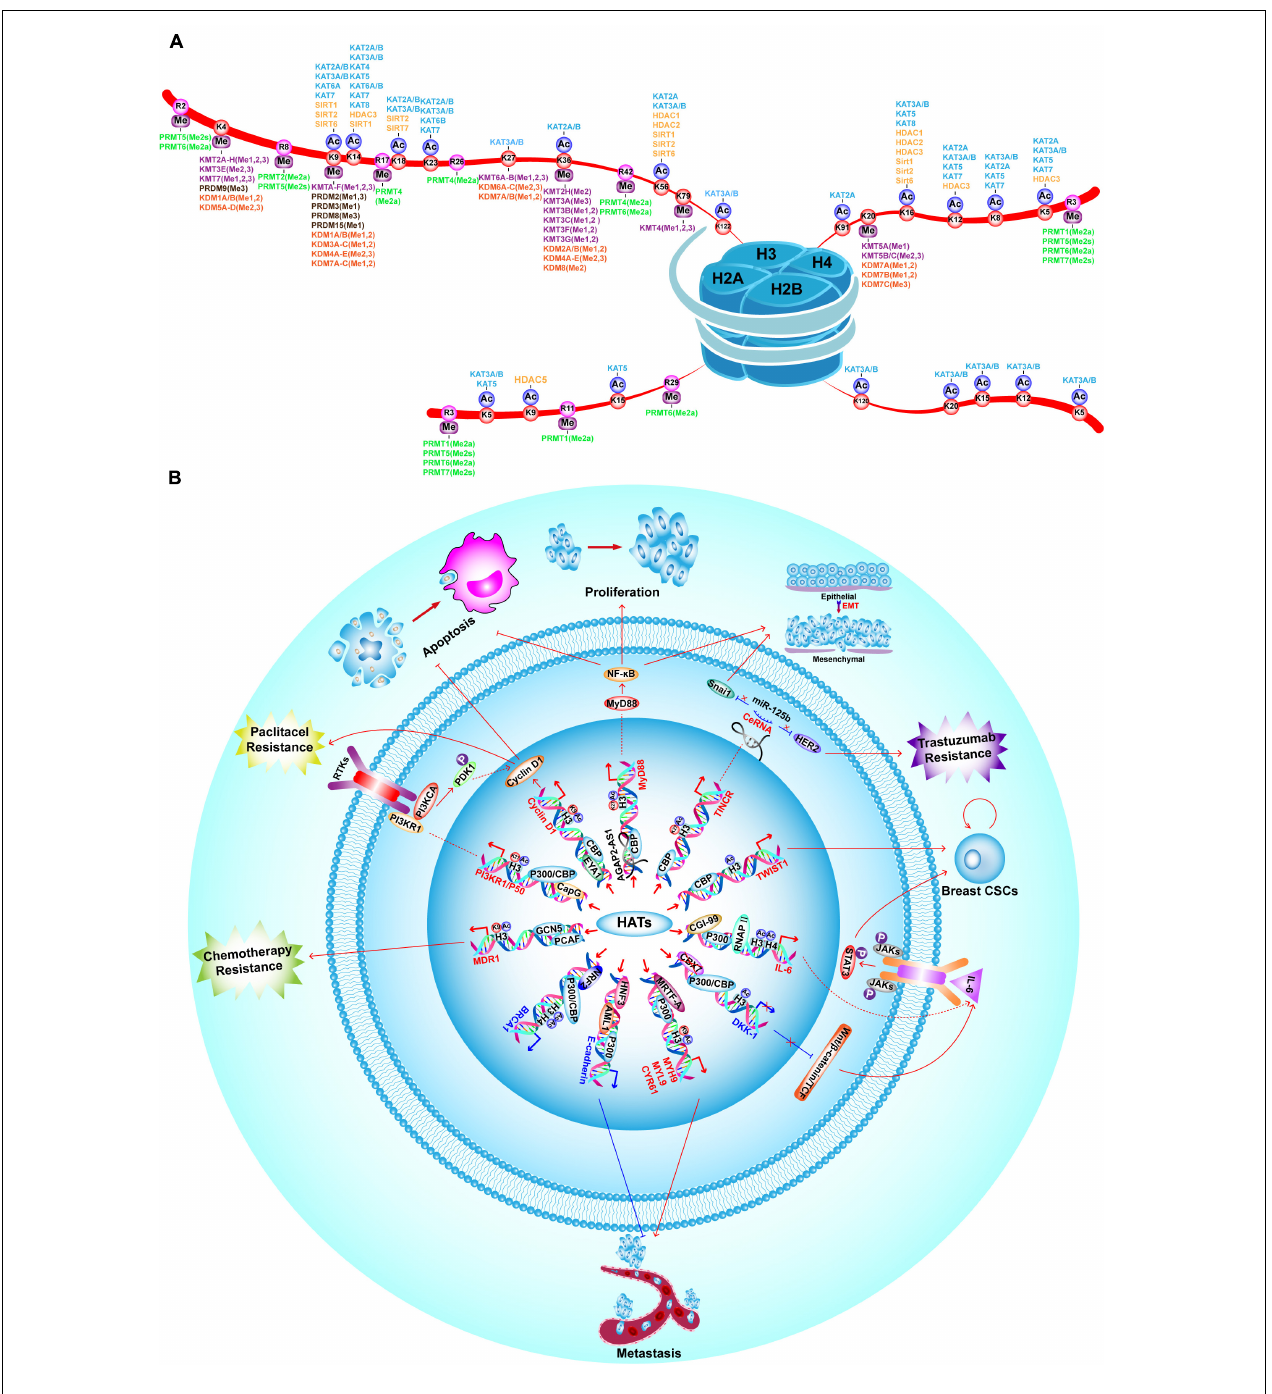
FIGURE 3 | Landscape of HM modifiers with their substrates, and the functions of HATs in BC. (A) Landscape of histone acetylation and methylation writers, erasers and their catalyzed substrates. (B) HATs promote BC proliferation, invasion and metastasis, drug-resistance, EMT, CSC properties and inhibit apoptosis by enhancing transcription of oncogenes, such as TINCR , MyD88 , Cyclin D1 , PI3KR1/P50 , MDR1 , MYH9 , MYL9 , CYR61 , IL-6 , and TWIST1 . On the contrary, P300/CBP inhibit BC tumorigenesis, metastasis and CSC properties by enhancing transcription of TSGs, such as E-cadherin and BRCA1